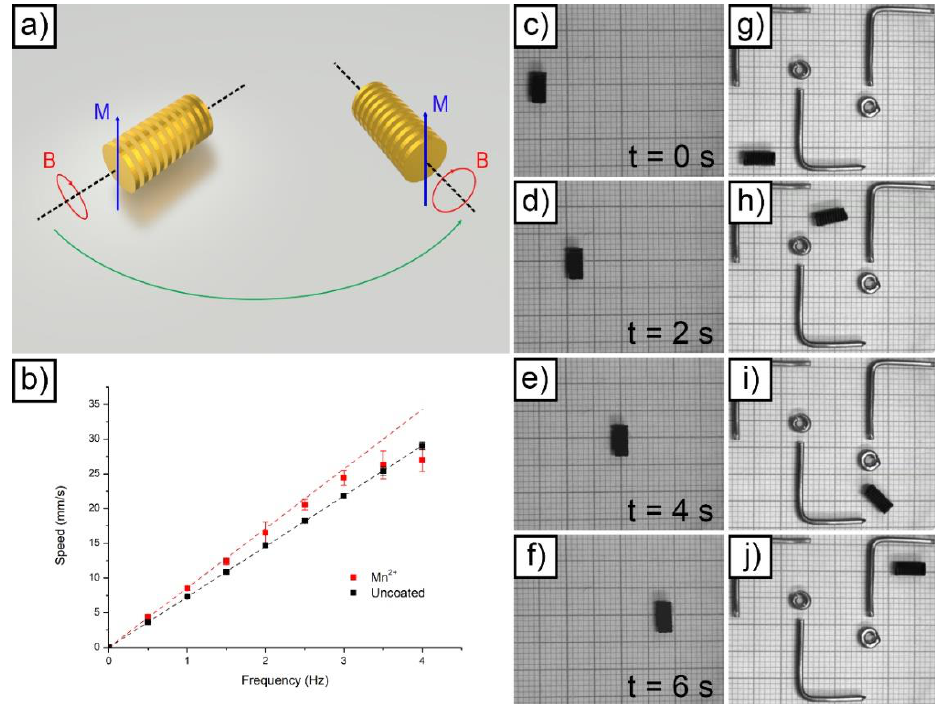
Figure 5. Schematic representation of the magnetic actuation principle employed for microrobots actuation ( a ); speed vs. frequency relationship for uncoated and Mn alginate-coated microdevices ( b ); linear actuation of a single Mn alginate-coated device (from ( c – f )); remote guidance of a Mn alginate-coated device to avoid metallic obstacles (from ( g – j )).